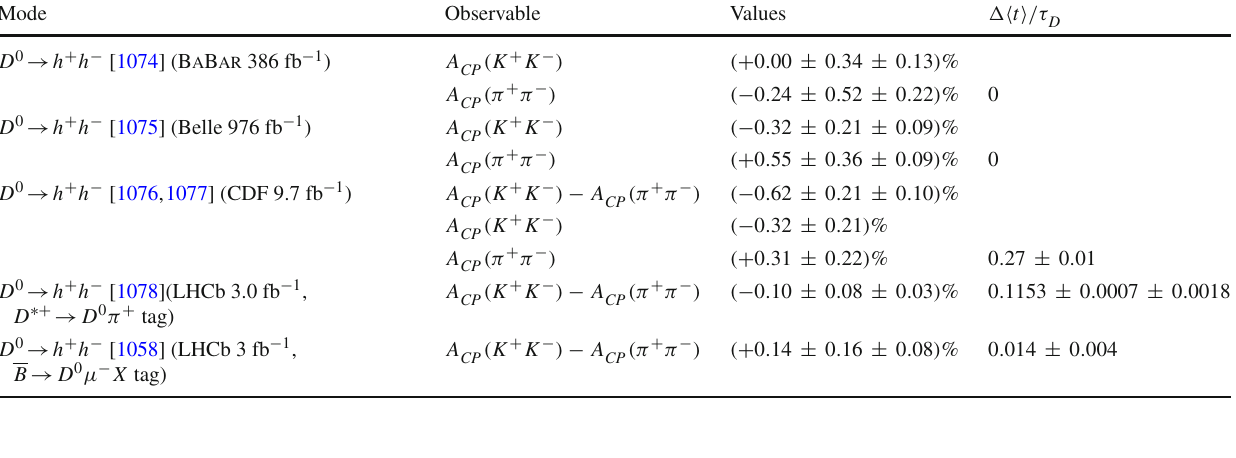
Fig. 191 World average value = ( x 2 + y 2 )/ 2 from Ref. of R M [1060], as calculated from D 0 → K + (cid:12) − ¯ ν